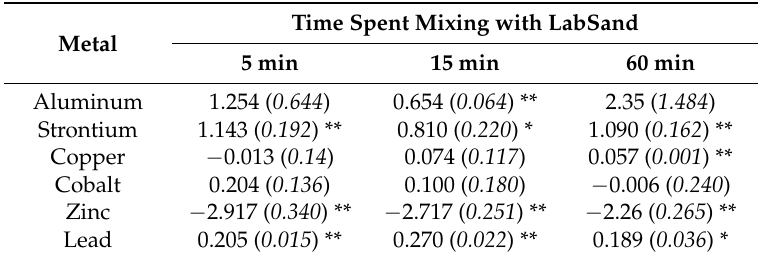
Table 1. Changes in spiked metal concentrations after various times mixing with LabSand. Time Spent Mixing with LabSand Metal 5 min 15 min 60 min Aluminum 1.254 ( 0.644